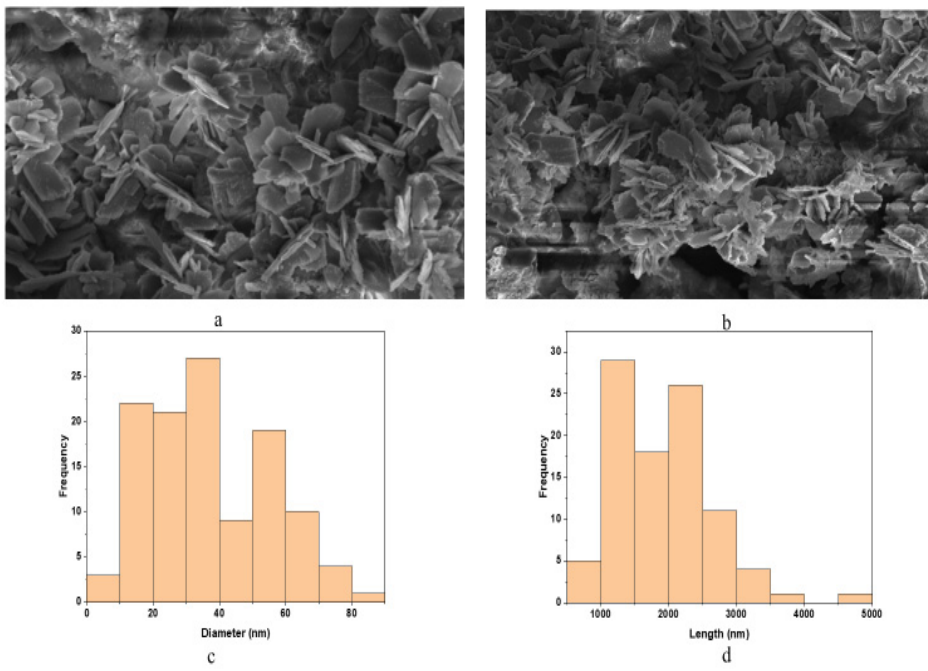
Figure 4. Scanning electron microscope (SEM) image of Sg -CuO NPs at 2 µm and 3 µm ( a , b ). ( c , d ) are the graphical representations of the diameter and length of the formed needle-shaped nanoparticles size measured with image J software, which gave the average diameter of the nanoparticle as 33 nm, and the average length as 1051 nm.